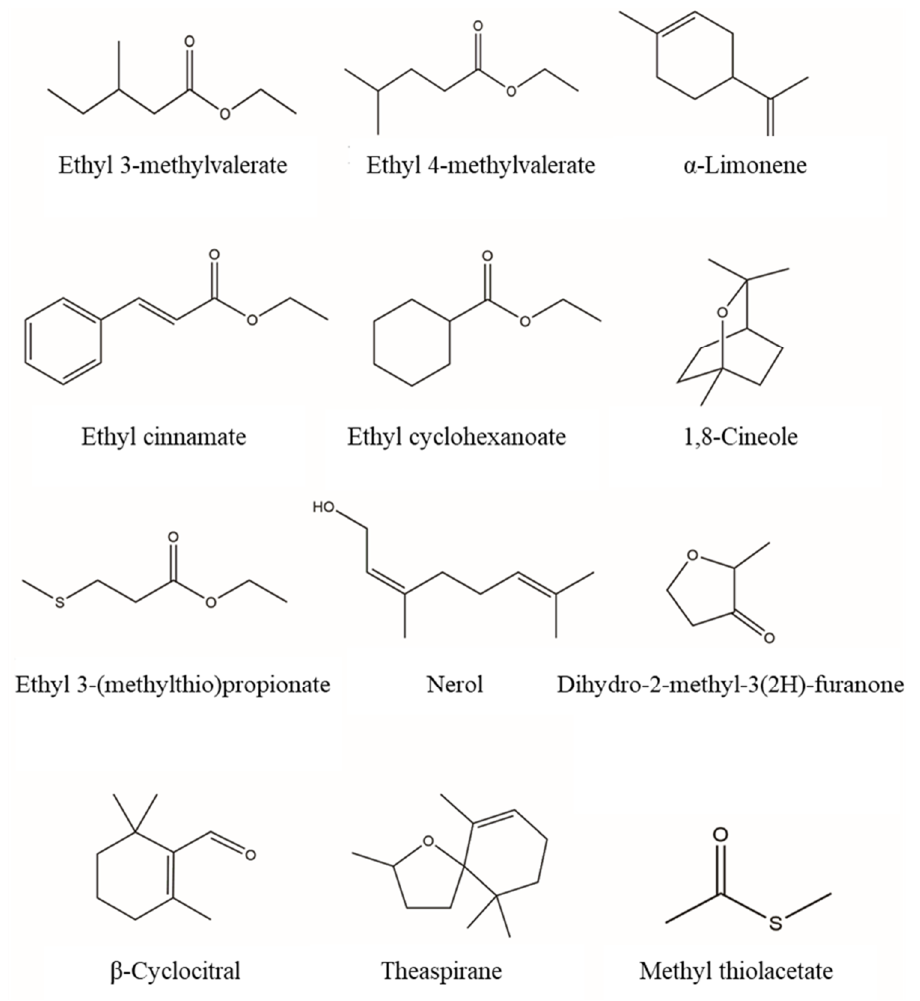
Figure 5. Chemical structure of some aroma compounds first reported in Chinese herbaceous aroma-type Baijiu.